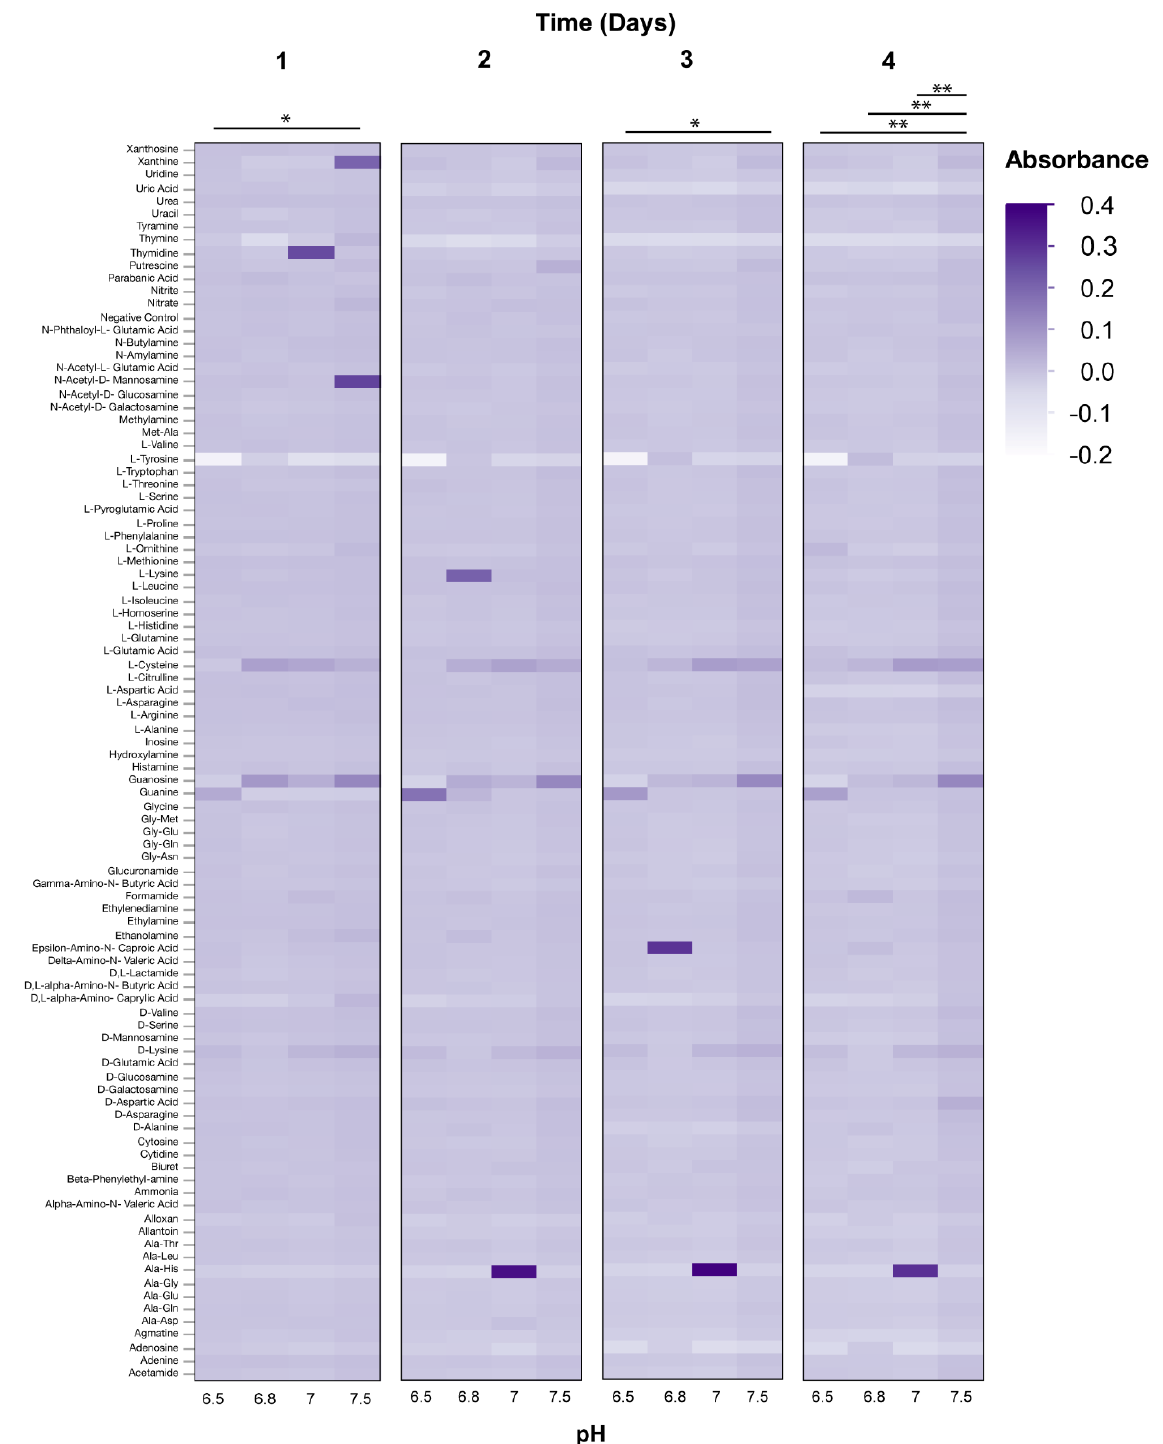
Figure 3. Heat map of PM3 phenotypic microarray data from Wolbachia isolated and maintained in Schneider’s medium supplemented with 10% fetal bovine serum (FBS) at different pH levels ( n = 3 for each treatment) All data were normalized by subtracting absorbance values of control plates containing Schneider’s medium only from absorbance readings of treatment plates. Significant differences between treatments are represented by horizontal bars above each column for each timepoint (t-tests, * p < 0.05, ** p < 0.005, *** p < 0.0005).